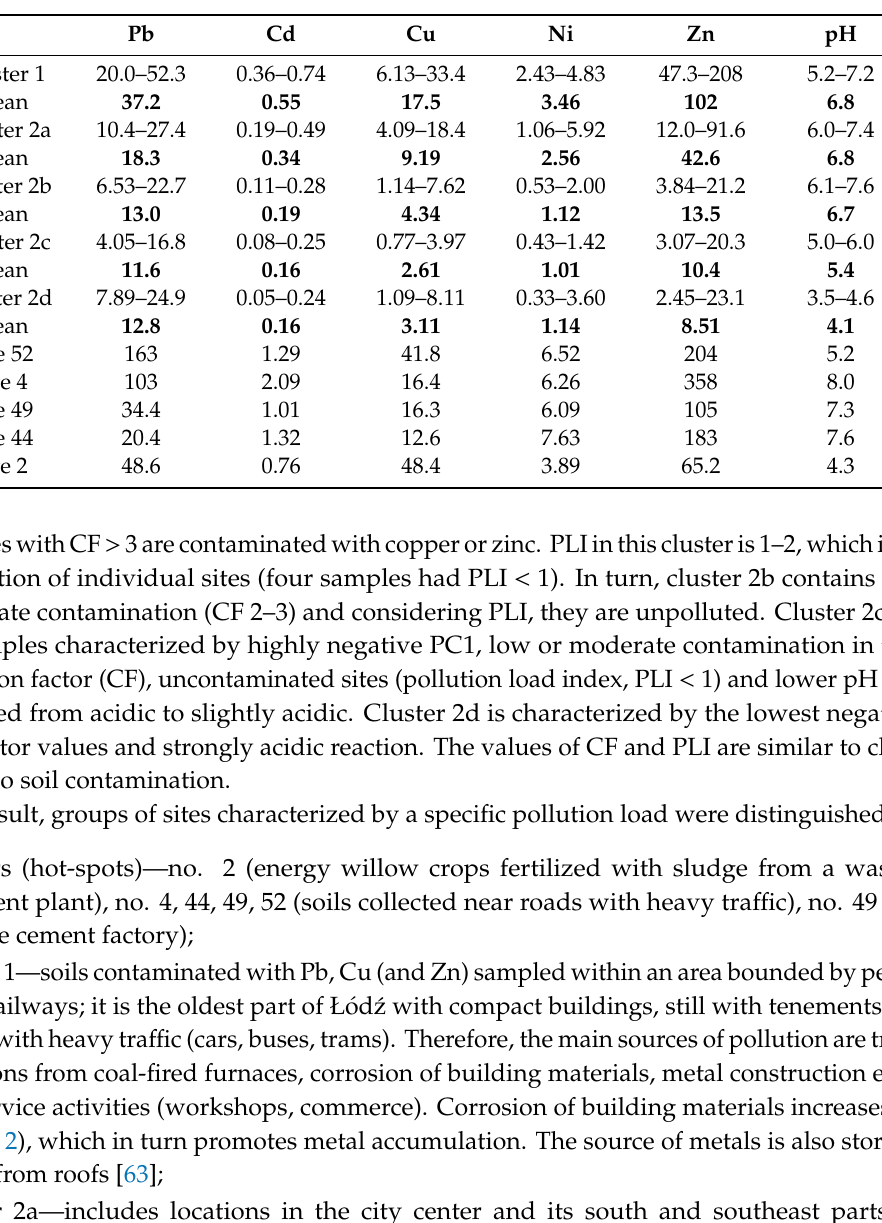
Figure 6. Factor values obtained from principal component analysis (PCA) for sampling points and classified according to the cluster analysis (CA) results. Table 2. Metal contents (mg kg − 1 ) and pH values for clusters and